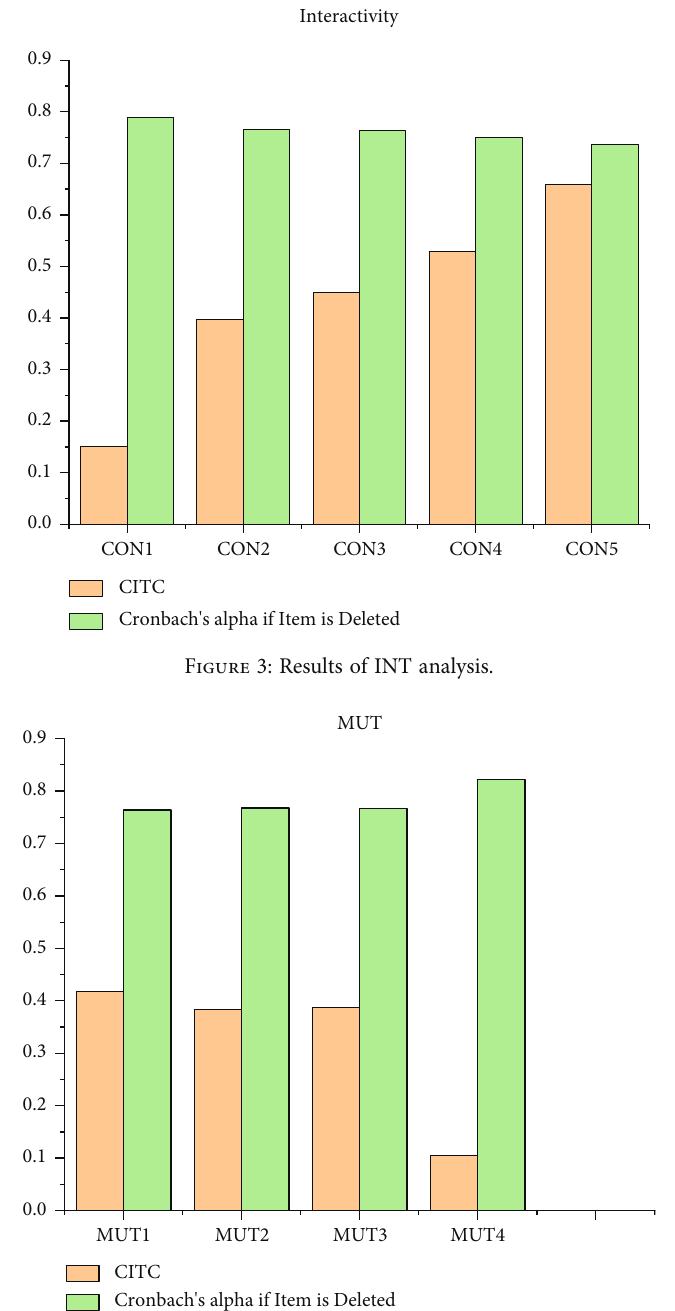
Figure 4: Results of MUT